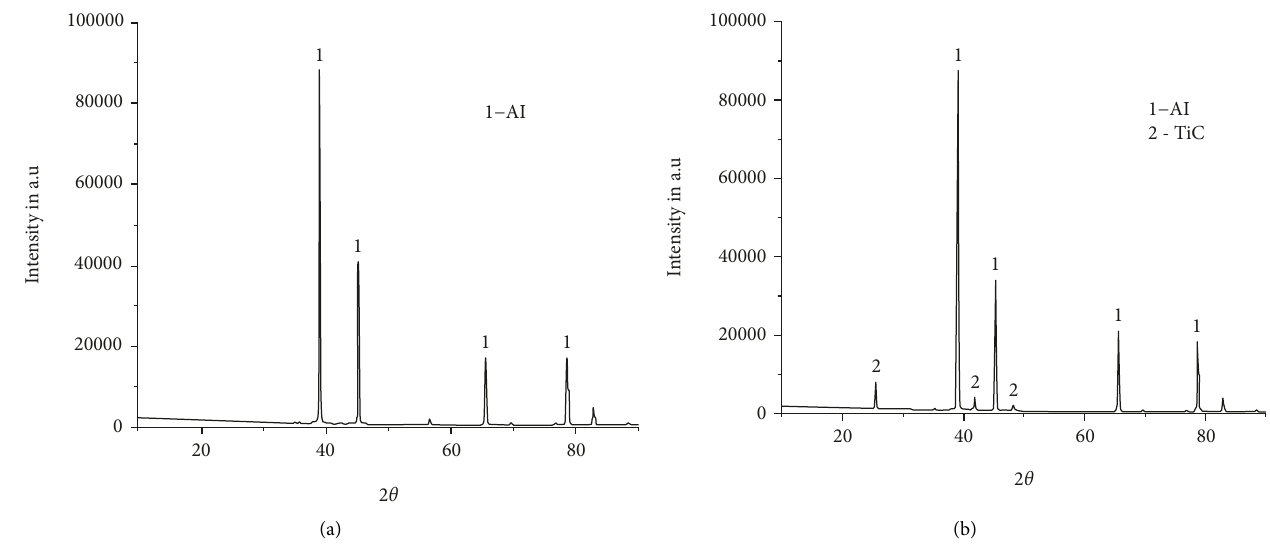
Figure 5: XRD patterns of (a) as-cast Al7075 and (b) Al7075-6wt% TiC